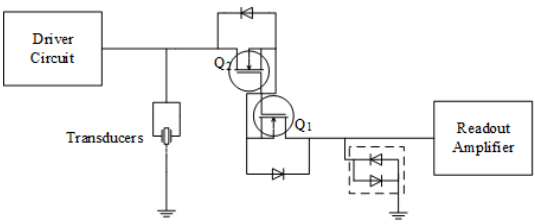
Figure 8. Schematic of the automatic protection circuit.